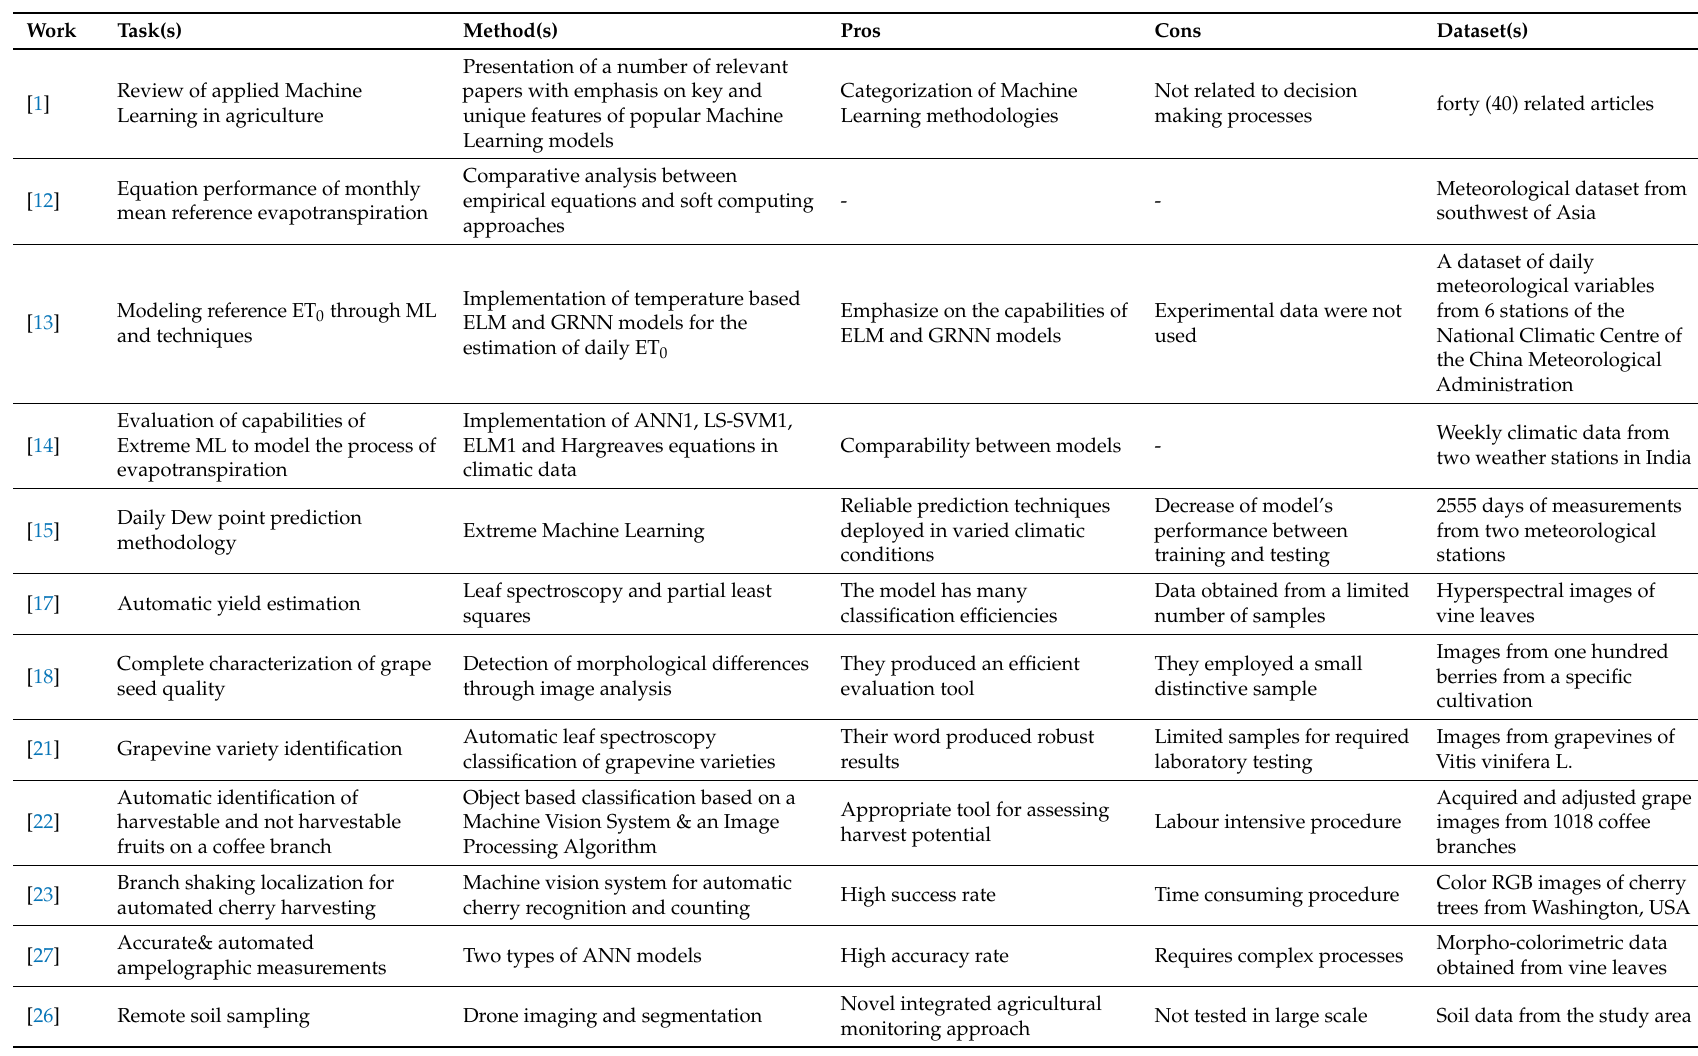
Table 2. Overview of research works focused in the utilization of